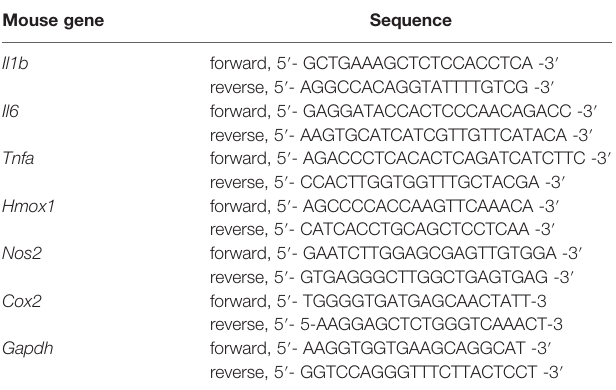
TABLE 1 | Sequences of the real-time PCR